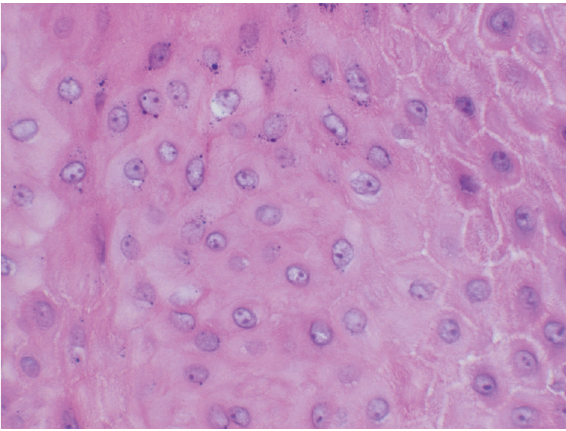
Figure 3: Well-differentiated squamous epithelium with ground- glass cytoplasm without atypia, dysplasia, or viral cytopathic effect.